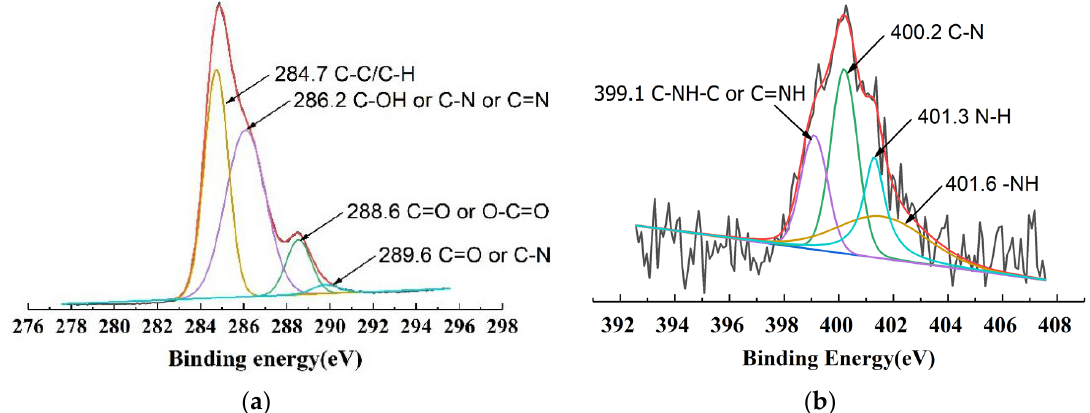
Figure 9. High-resolution XPS C 1s ( a ) and N 1s ( b ) spectra for the insoluble matter of SADP 2.